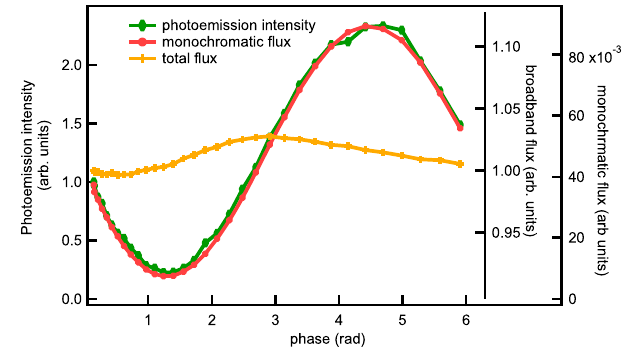
Fig. 1 Measured resonant photoemission intensity at binding energy 2.5 eV (green curve), monochromatic fl ux (red curve) and total fl ux (orange curve) as a function of phase. The photoemission intensity and monochromatic fl ux are plotted on different axes from zero and scaled so the maxima overlap. Both curves vary from 10% to 100% of the maximum. Note the expanded scale for the total fl ux: the fl ux varies from 97% to 100% of the maximum. Photon energy: 38 eV.